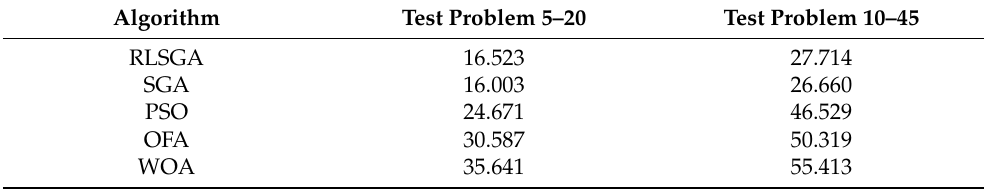
Table 4. Comparison of average running times of five algorithms on test problems 5–20 and